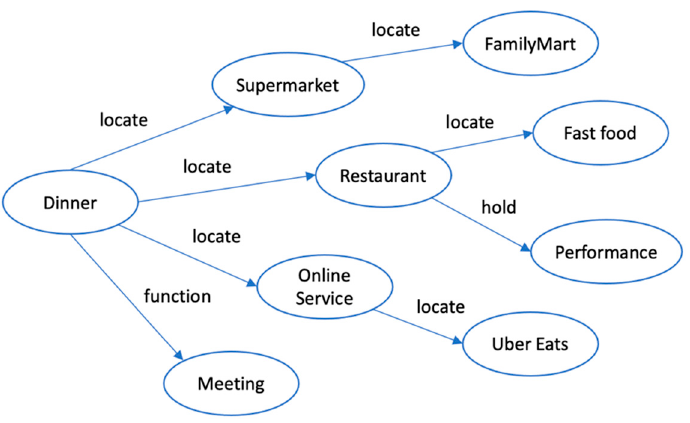
Figure 7. The part of knowledge graph in step